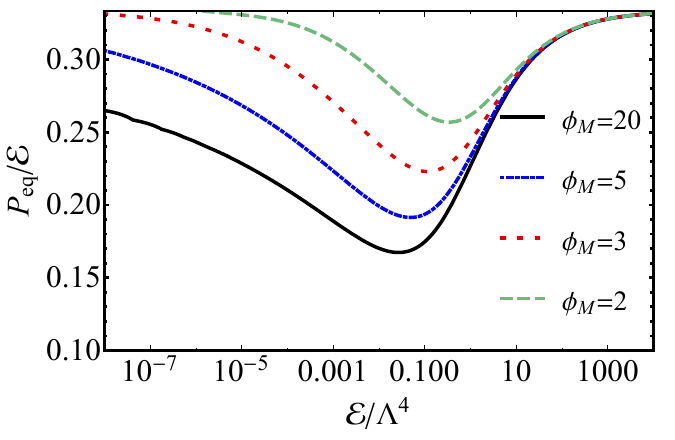
Figure 2 . Equilibrium pressure as a function of energy density for (cid:30)